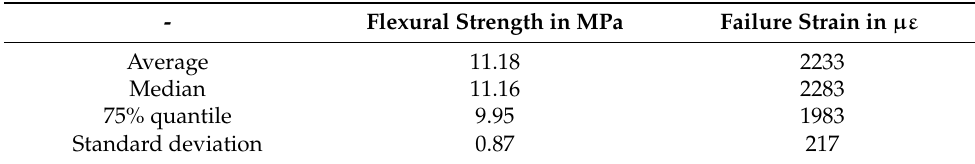
Table 3. Statistical results of flexural strength tests. - Flexural Strength in MPa Failure Strain in µε Average 11.18 2233 Median 11.16 2283 75% quantile 9.95 1983 Standard deviation 0.87